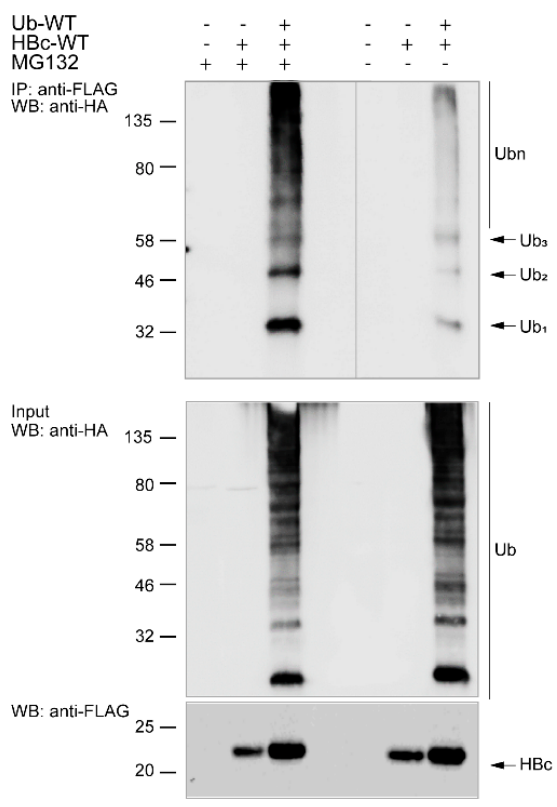
Figure 2. HBc is modified by ubiquitin in Huh7 cells. Western blots of cell lysates immunoprecipitated with anti-FLAG magnetic beads after co-transfection of Huh7 cells with FLAG-tagged HBc-WT and HA-tagged Ub-WT. The cells were treated 48 h post-transfection with 50 µM MG132 for 5 h. After the treatment, all cells were harvested and precleared cell lysates (1 mg of proteins, WB: Input 10 µg of total protein/lane) were immunoprecipitated with anti-FLAG magnetic beads. For HBc detection, the antibody against FLAG-tag was used.